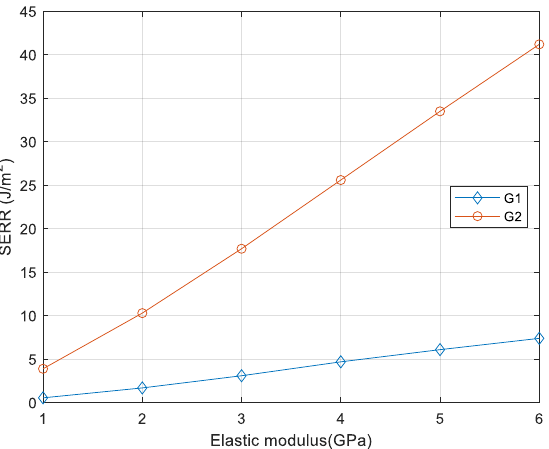
Figure 7. ( a ) Stress intensity factor, phase angle as function of crack length, and ( b ) strain energy release rate as function of crack length.